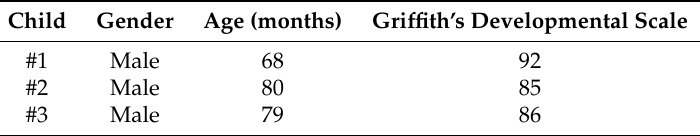
Figure 9. An example of toys disposition in the closet. Table 3. Children gender, age and Griffith’s Developmental